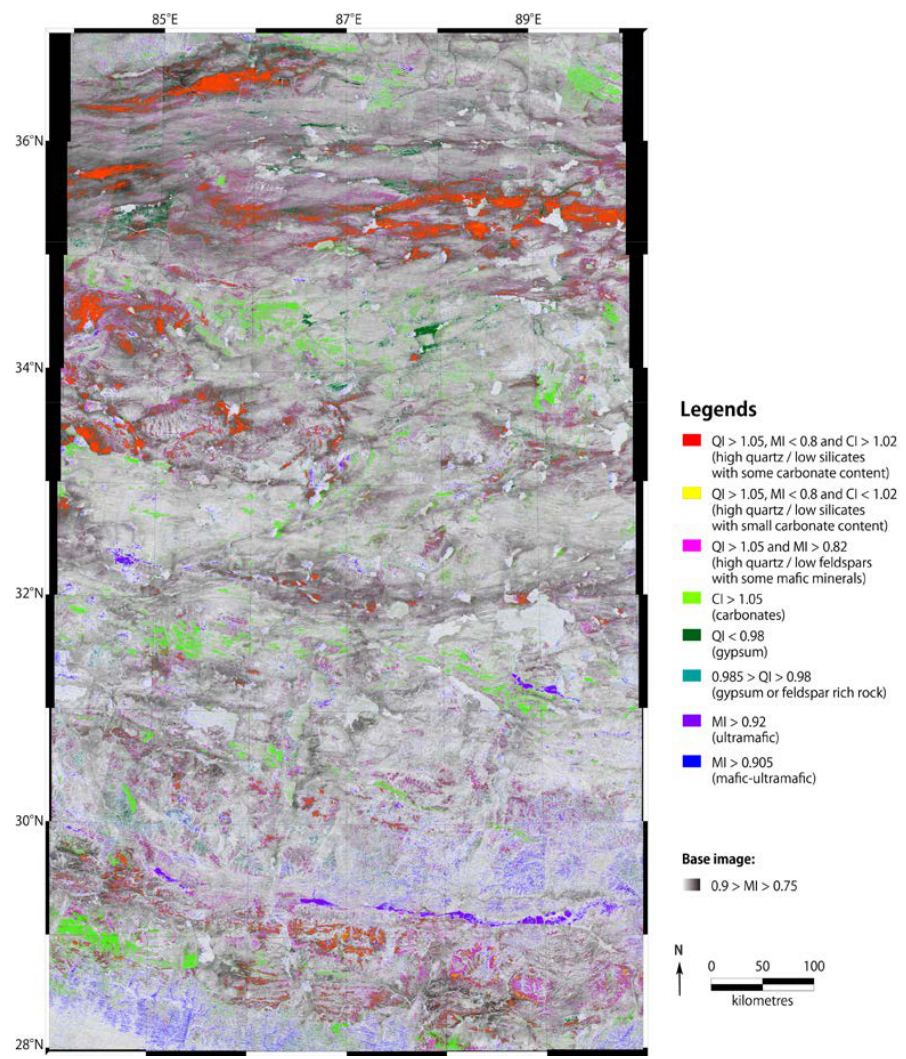
Figure 6. Detected possible rock types colored for each pixel with the given conditions (see legend) on the indices mapped on the grayscale image of MI (0.75–0.9).